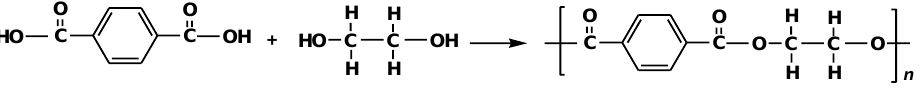
Figure 1. Structure of Polyethylene terephthalate.